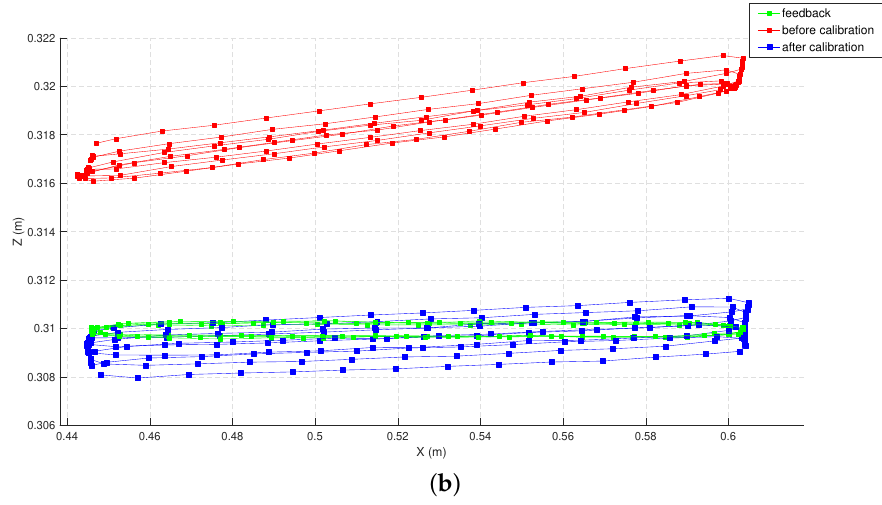
Figure 14. Estimated end-effector position before and after calibration (down-sampled by 10) plotted along with the feedback positions. ( a ) Top view (X-Y plane). ( b ) side view (X-Z plane).